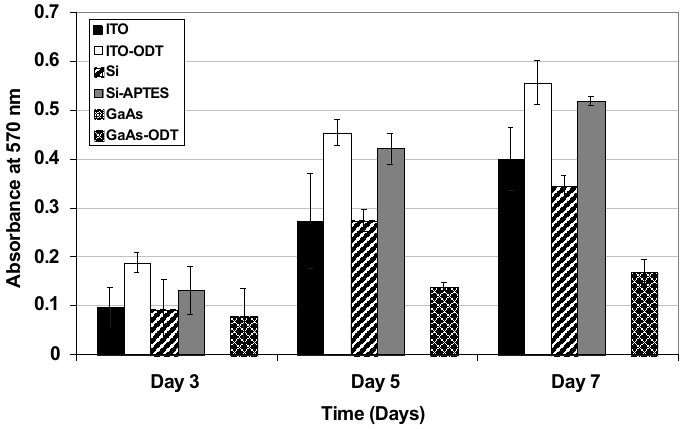
Figure 6. Proliferation of HDFs on SAM-modified and unmodified Si, GaAs and ITO surfaces after 3, 5 and 7 DIV. Data represent the mean ± S.D, n = 3.